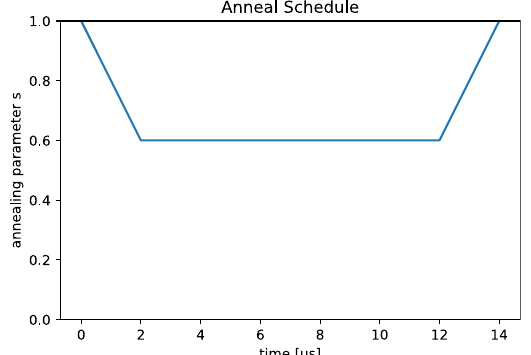
Figure 4. A reverse annealing schedule used in our study plotted with respect to the evolution of the dimensionless parameter s .